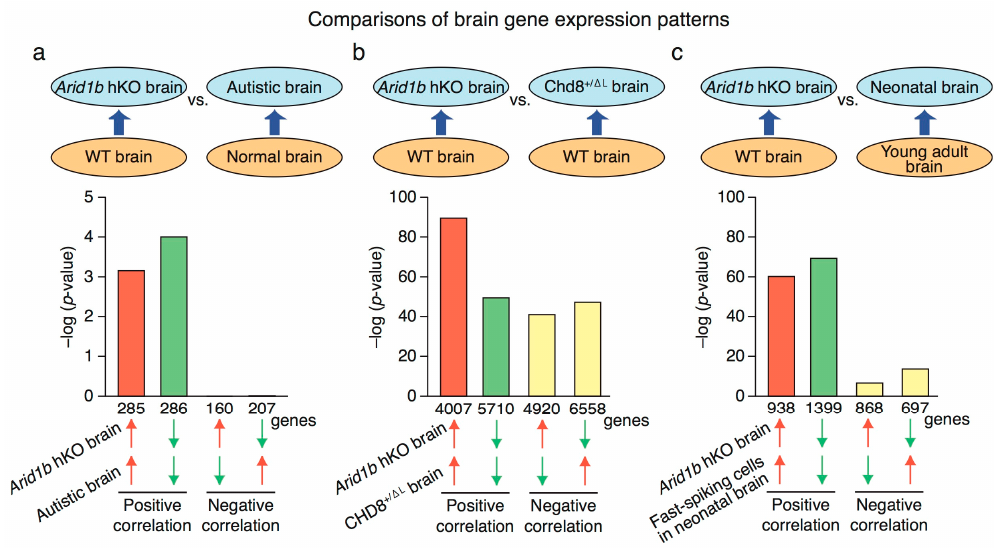
Figure 4. Comparison of brain gene expression patterns in Arid1b hKO mice with other genomic data. ( a ) Comparison of brain gene expression patterns in Arid1b hKO mice with those in autistic patients; ( b ) Chd8 -haploinsufficient mice, and ( c ) fast-spiking cells in 7-day-old mouse pups. Arrows show up regulated gene group (red) or down regulated gene group (green).